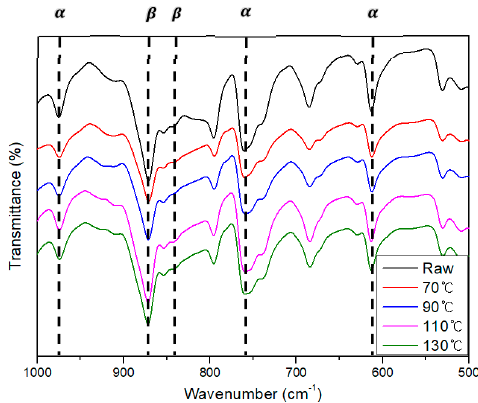
Figure 6. Tensile strength and tensile modulus of the PVDF/PAR composites prepared at different molding temperatures.